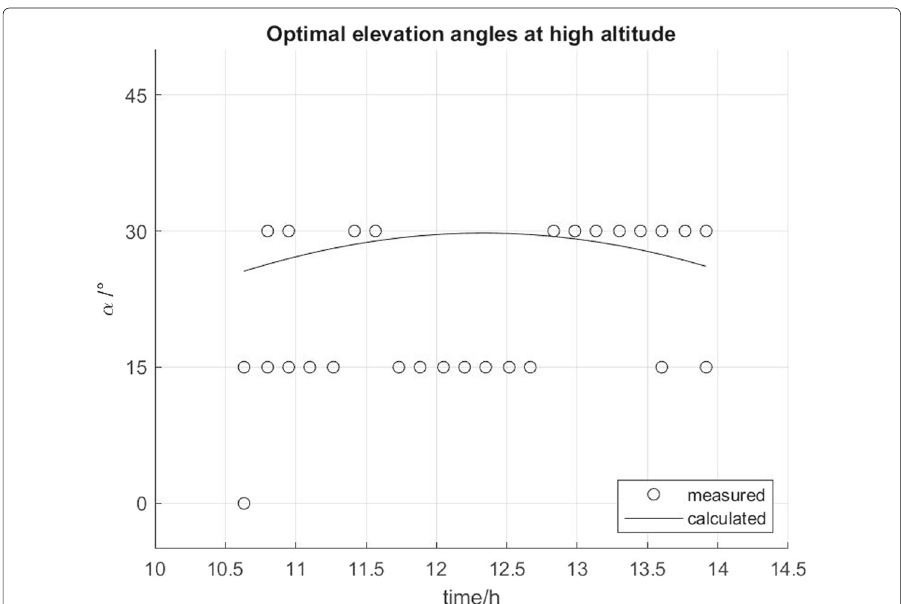
Fig. 12 Optimal elevation angles at high altitude